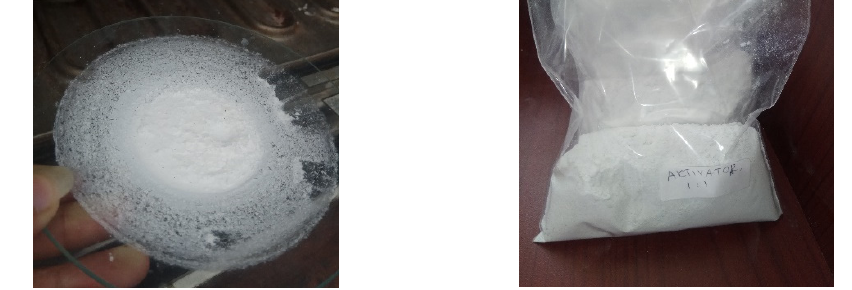
Figure 1. Dry activator synthesized by mixing NaOH and geothermal silica with a ratio of 1:1 (wt./wt.) and then calcining at 400 °C.